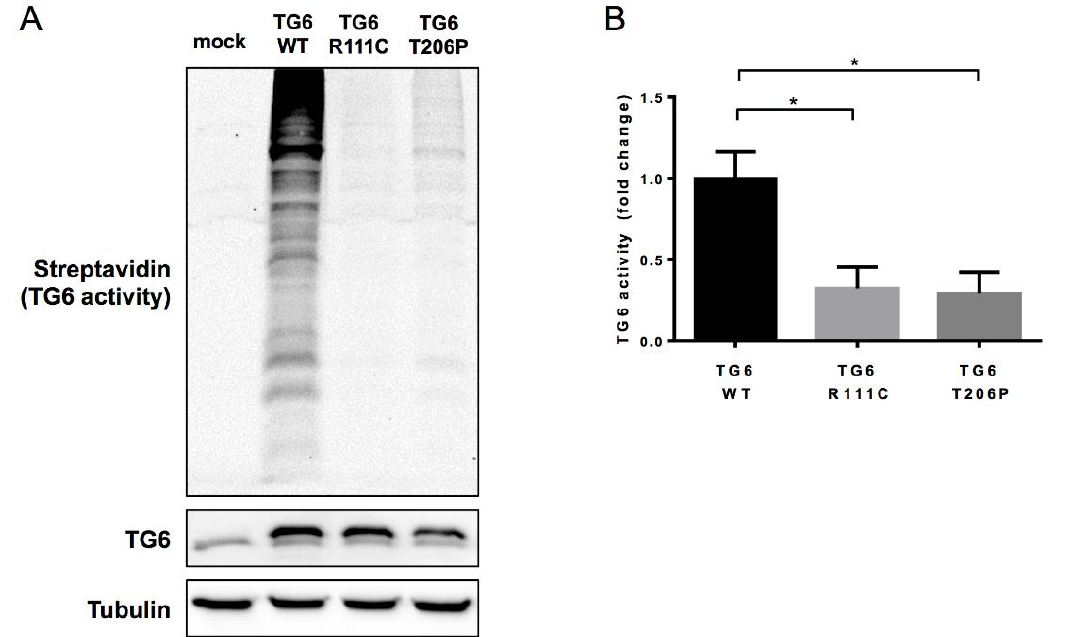
Figure 4. In vitro assay showing TG6 transamidase activity: ( A ) Western blotting analysis showed significantly compromised transamidase activity of the TGM6 T206P variant compared to wild-type TG6 protein. ( B ) Quantification of TG6 enzymatic activity from experiment shown in panel A. Graph, mean ± SEM, * p <0.05, one-way ANOVA with Tukey’s post hoc test. Y-Axis represents the fold change.